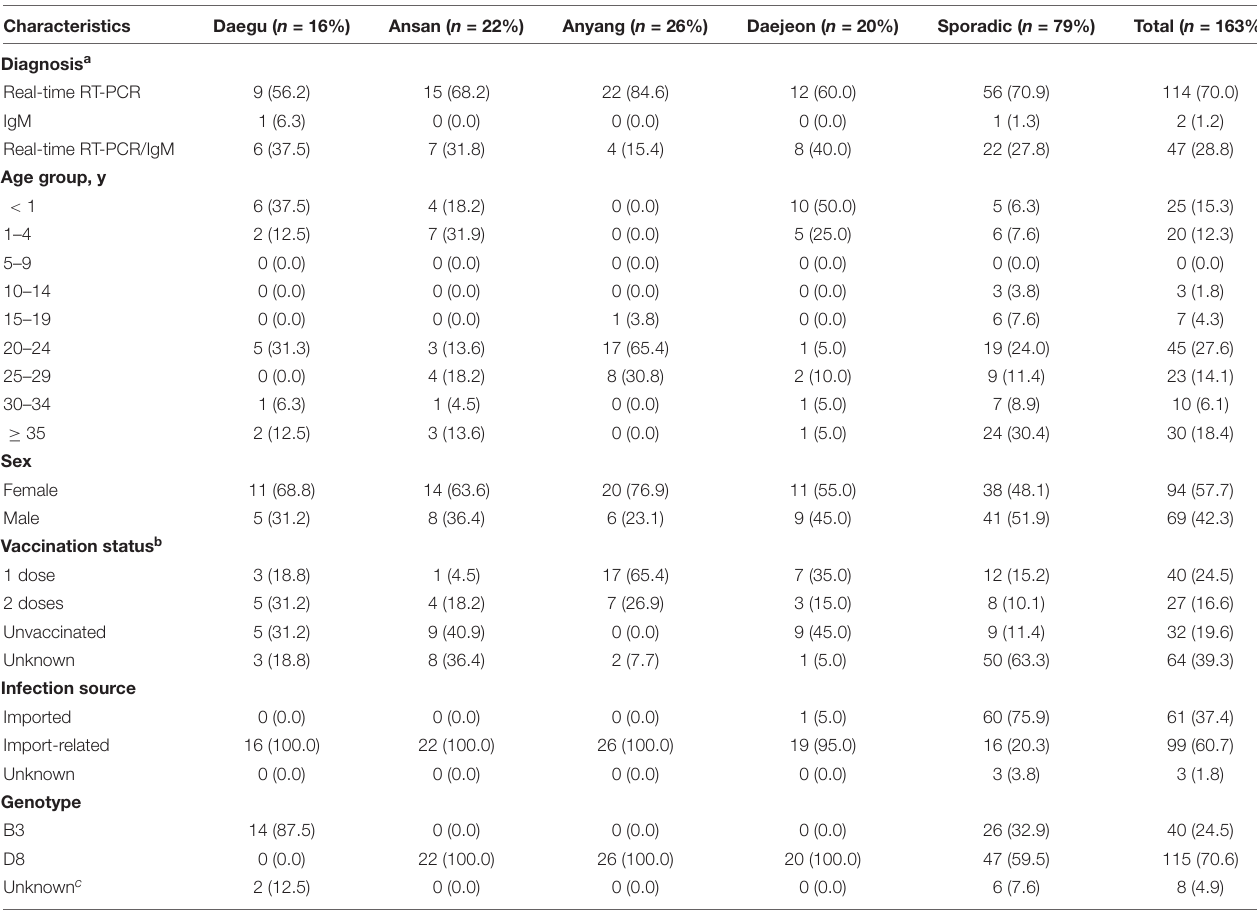
TABLE 1 | Characteristics of 163 confirmed cases of measles in South Korea, December 2018–May